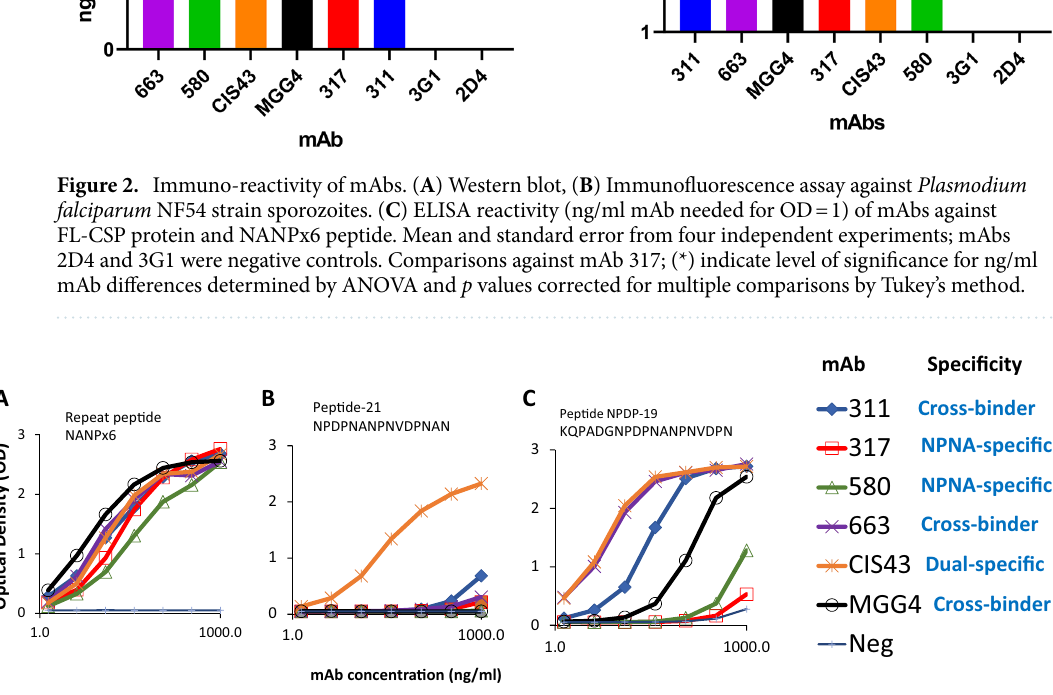
Figure 3. Epitope-specificity. Raw ELISA curves showing mAb binding patterns: ( A ) Target peptide NANPx6, ( B ) peptide-21 (NPDPNANPNVDPNAN) and ( C ) peptide NPDP-19 (KQPADGNPDPNANPNVDPN. Negative control wells (Neg) contained no primary antibody; a representative of three independent ELISA experiments was